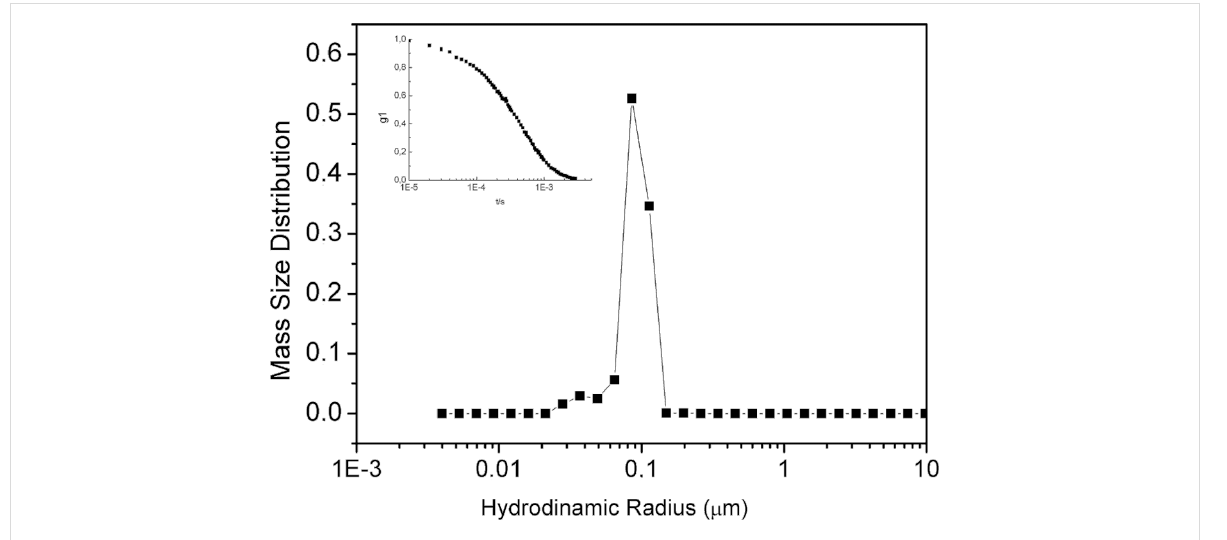
Figure 7: R H distribution by CONTIN (and Mie scattering normalization) analysis of SC2OH dispersion (2 mg mL − 1 ) in dichloromethane. The inset shows the correspondent scattered electric field autocorrelation function at scattering angle of